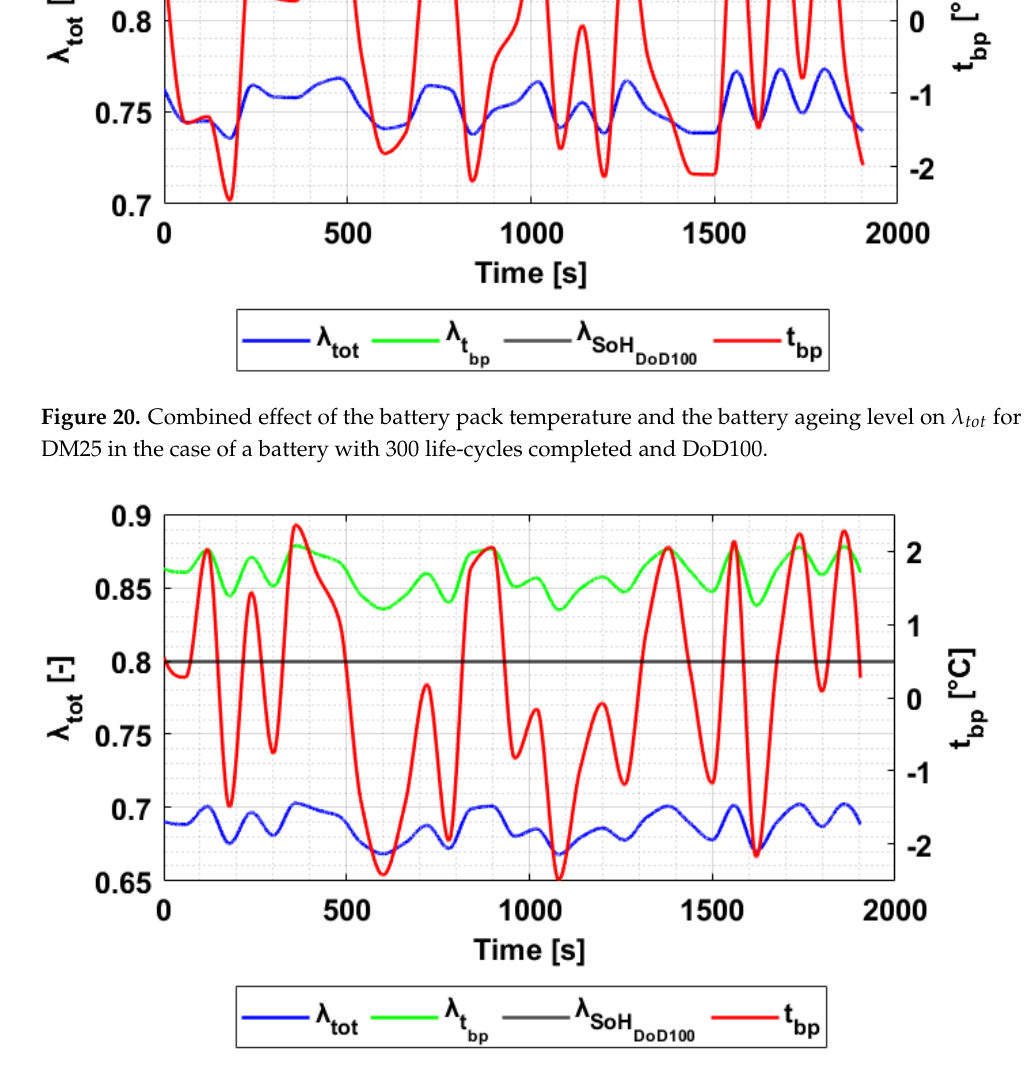
Figure 21. Combined effect of the battery pack temperature and the battery ageing level on λ tot for DM25 in the case of a battery with 400 life-cycles completed and DoD100.